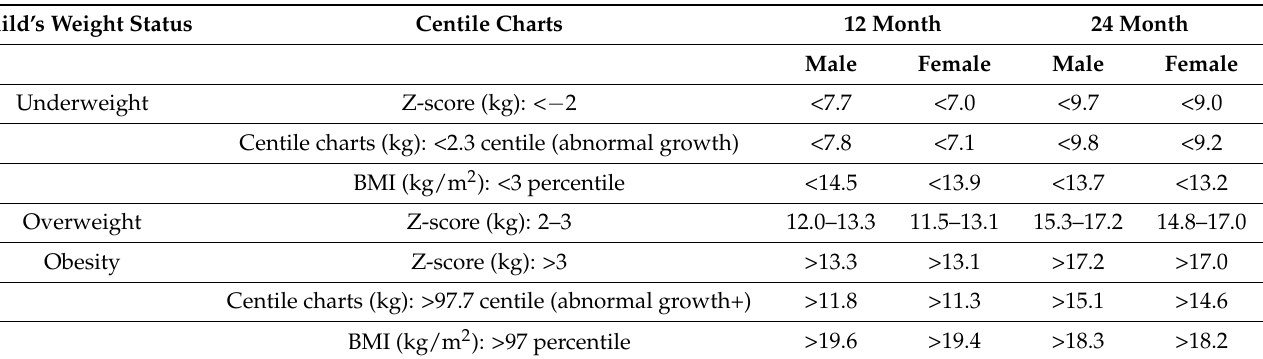
Table 1. The prevalence of underweight, overweight and obesity in the study group according to the different